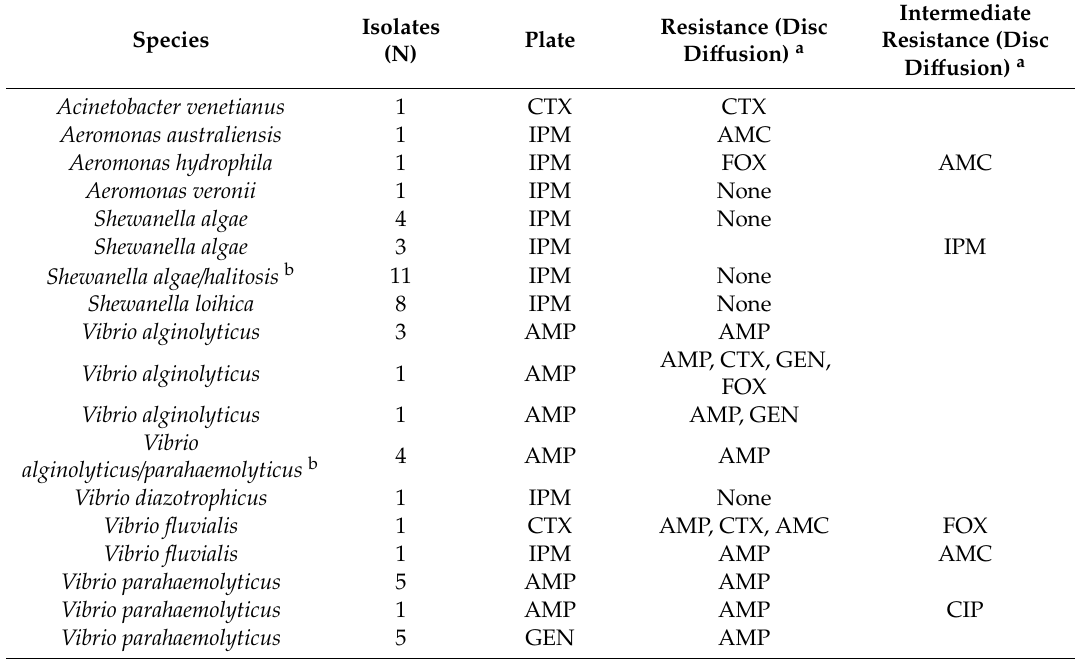
Table 3. Species and antibiotic resistance profiles of bacteria recovered from estuarine sediments in San Francisco Bay, 2015, from drug-supplemented media. Plate: Drug supplementation on plate (see